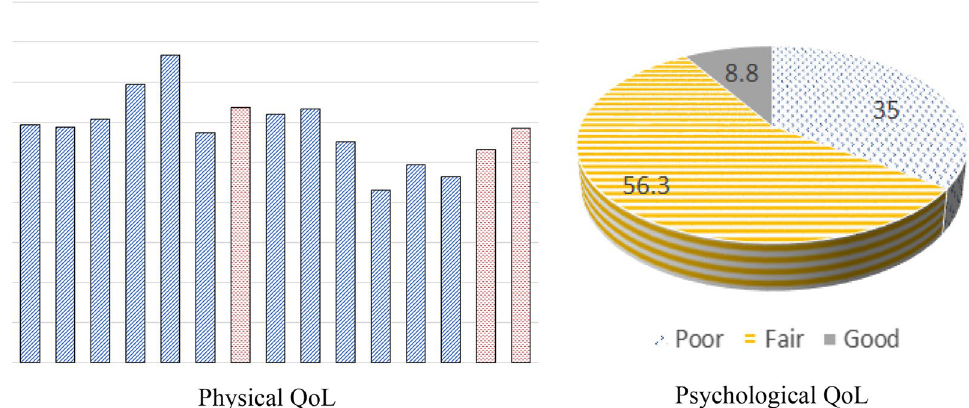
Fig. 1 Distribution of physical and psychological QOL domain by the study